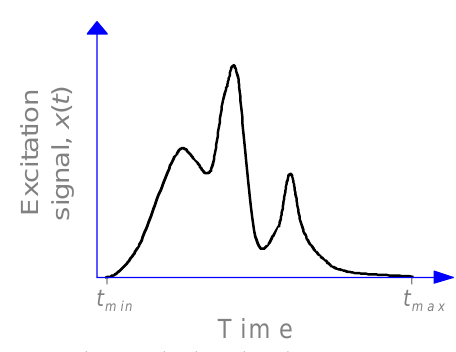
Figure 1: Transient excitation